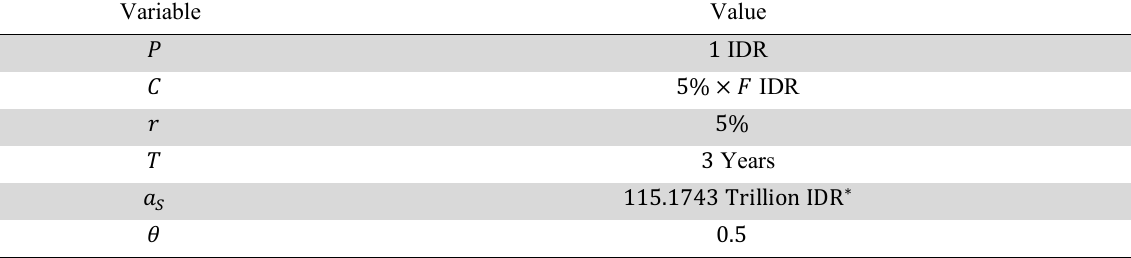
The Values of Variables for FCB Price Estimation Variable